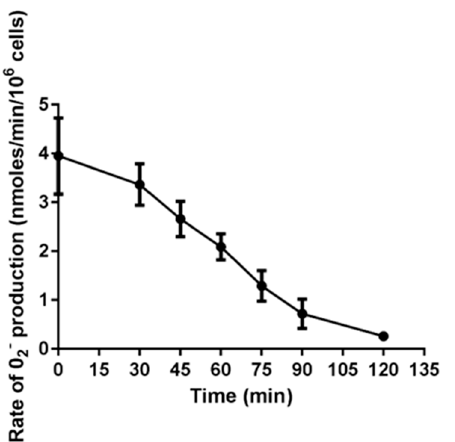
Figure 4. Rate of oxidant production in response to PMA. Neutrophils were stimulated with NET- inducing concentrations of PMA (20 nM) and the rate of superoxide production was monitored with cytochrome c. Measurements were for 5 min and rates taken from the steepest part of the slope. Data are means (SE) from 3–6 individual experiments.